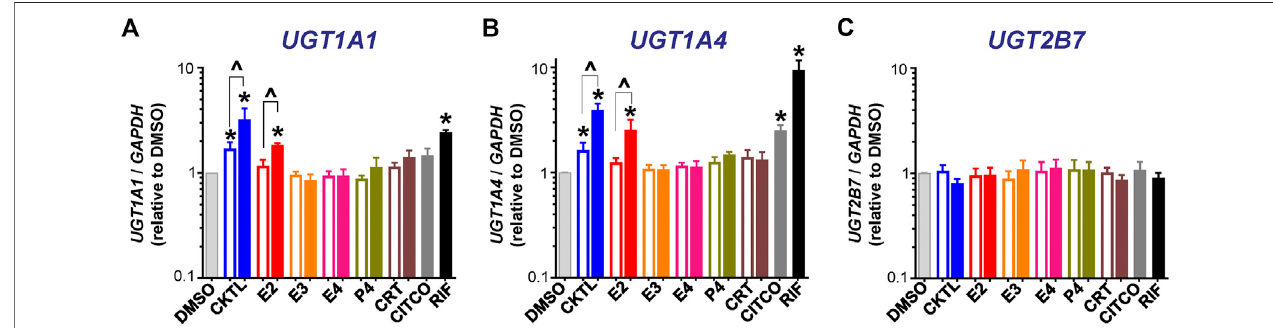
FIGURE 1 | Effect ofpregnancy-related hormones (PRH) onmRNAlevelsofkey UGT isoforms inSCHH. Hepatocytes fromfour donors (HU1880,HC3-26, HU8284, andHC5-40)wereexposedtoE2,E3,E4,P4,andCRT,individuallyorincombinationasaPRHcocktail[CKTL],orcontrols(DMSO,CITCO,Rifampin[RIF])for72 h( n (cid:2) 2per group within each hepatocyte donor). (A) UGT1A1 , (B) UGT1A4 , and (C) UGT2B7 mRNA levels were normalized to GAPDH and expressed relative to the vehicle control group (DMSO) withineach donor. The data werecombined for comparisonacross experimental groups ( n (cid:2) 4 donors per group;mean ± SEM; * p < 0.05vs. DMSO).